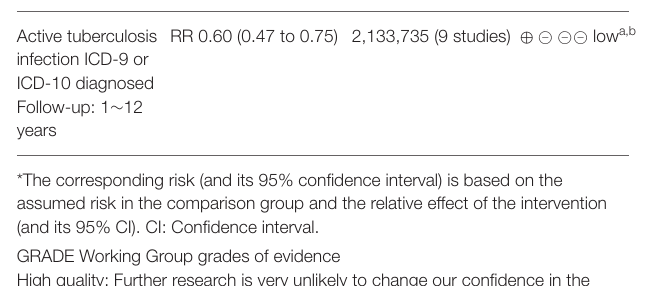
TABLE 3 | Summary of Findings Table. Statin use and the active tuberculosis infection risk Patient or population: Overall population or patients with or without the use of statins Settings: Overall population (diabetic or non-diabetic, with or without specific disease), clinical settings Exposure: Statin use Outcomes Relative effect No of Participants Quality of the (95% CI) (studies)